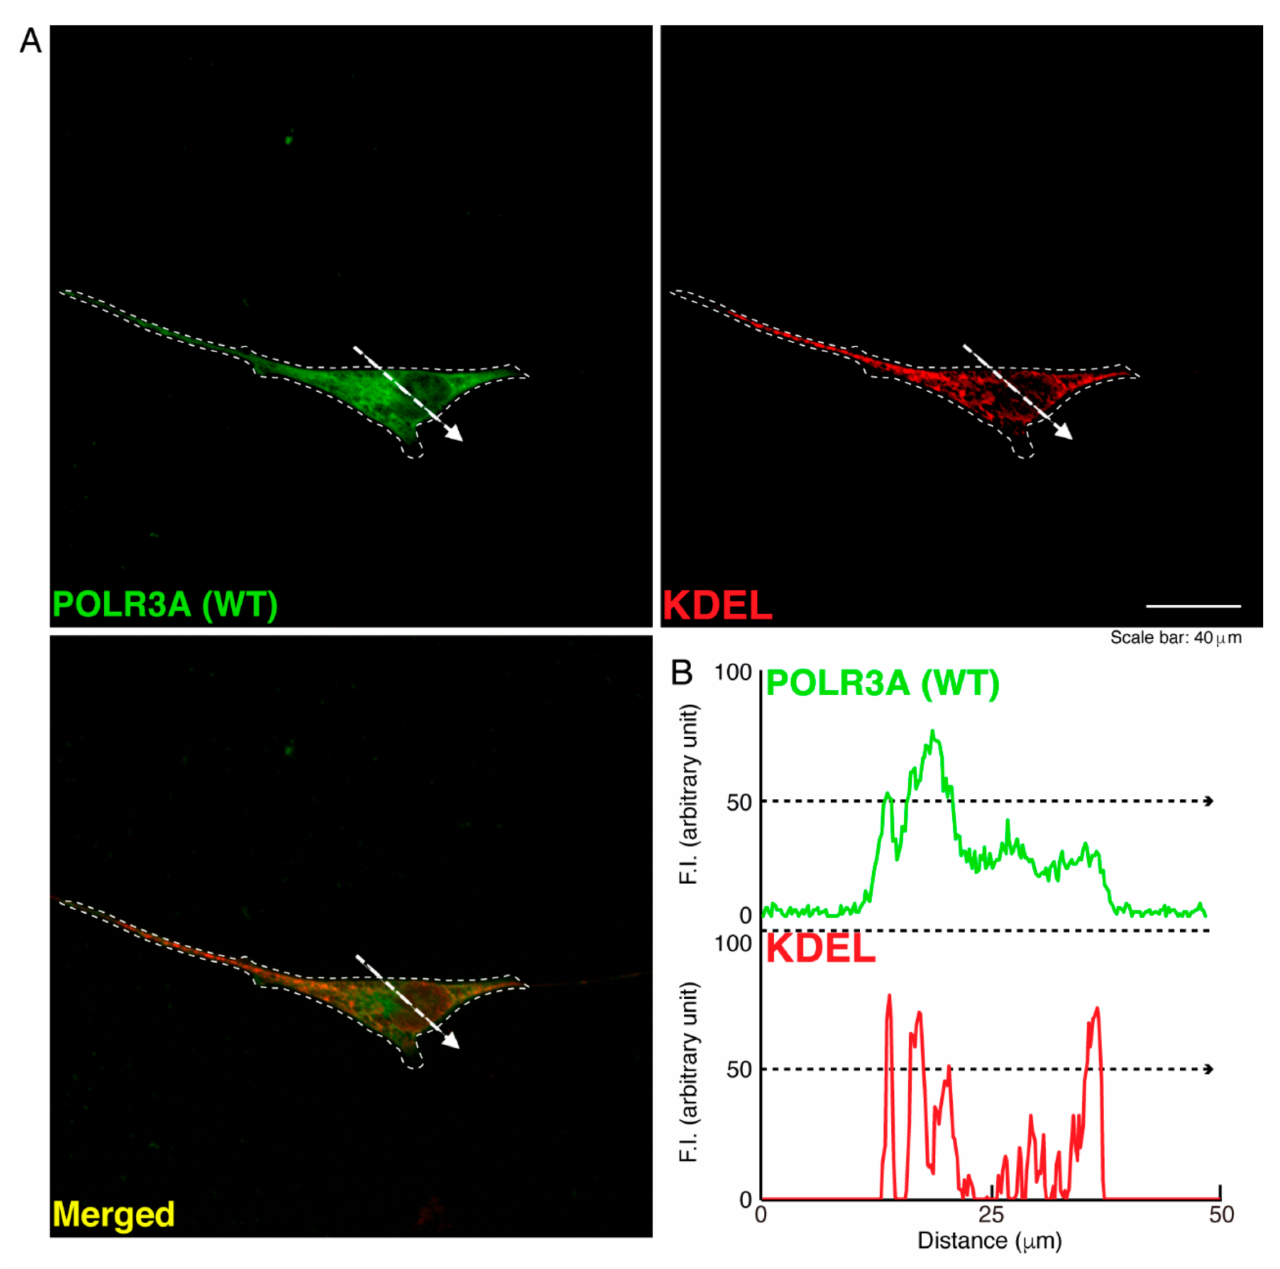
Figure 2. The wild type POLR3A proteins are not co-localized with the ER in cells. ( A , B ) FBD − 102b cells were transfected with the plasmid encoding the wild type (WT) POLR3A and stained with transfected proteins (green) and an antibody against the KDEL antigen (red). Scan plots were performed along the white dotted lines in the direction of the arrows in the color images (green and red as well as merged images). Graphs showing the fluorescence intensities (arbitrary units) along the white dotted lines in the direction of the arrows can be seen in the right bottom panels (black dotted